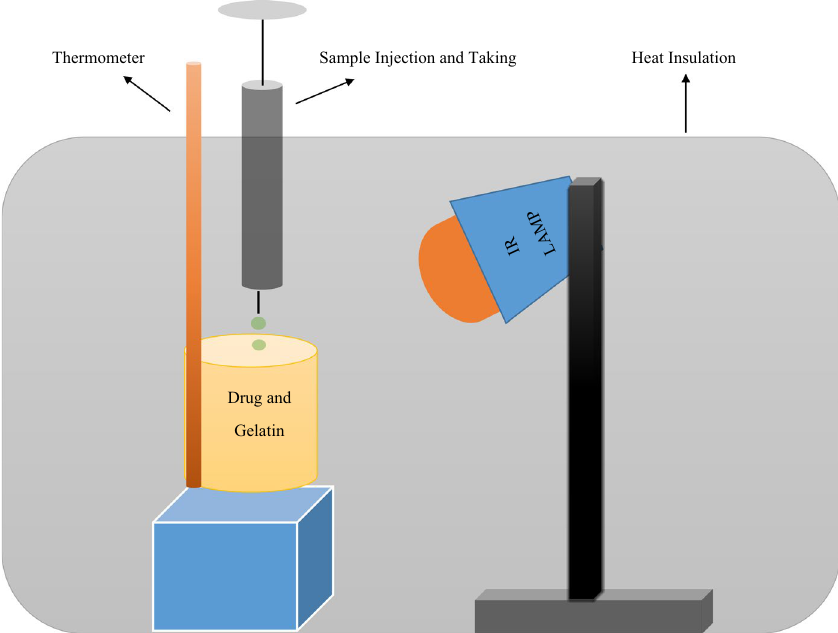
Figure 1. Schematic representation for preparation of CP loaded gelatin-based NPs by